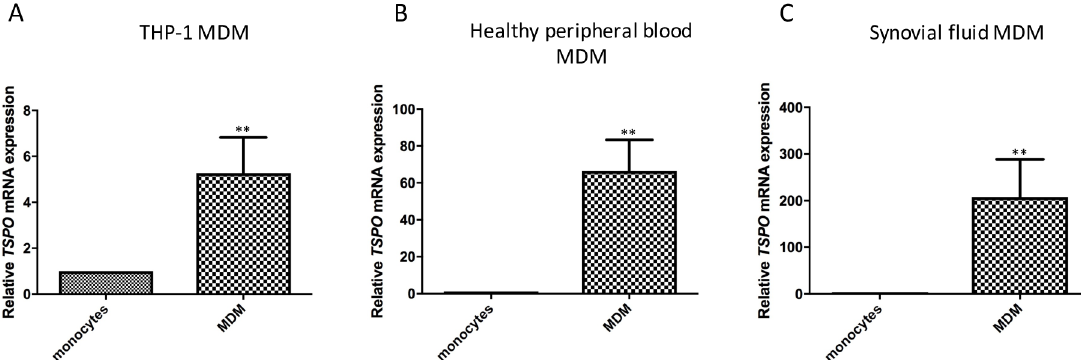
Fig 1. TSPO mRNA expression of monocytes compared to MDM. (A) THP-1 monocytes and THP-1 MDM; (B) healthy peripheral blood monocytesand corresponding MDM (C) synovialfluid monocytes and corresponding MDM. Results are expressedas fold change mRNA expression(compared to 18s RNA). Each experimentwas run in triplicate, with data expressedas mean ± SEM of five independentexperiments. Relative TSPO mRNA expressionin MDM was comparedto their respectivemonocyte counterpartwherebystatistically significantdifferences are noted as ** p < 0.001using Student’s t -test.